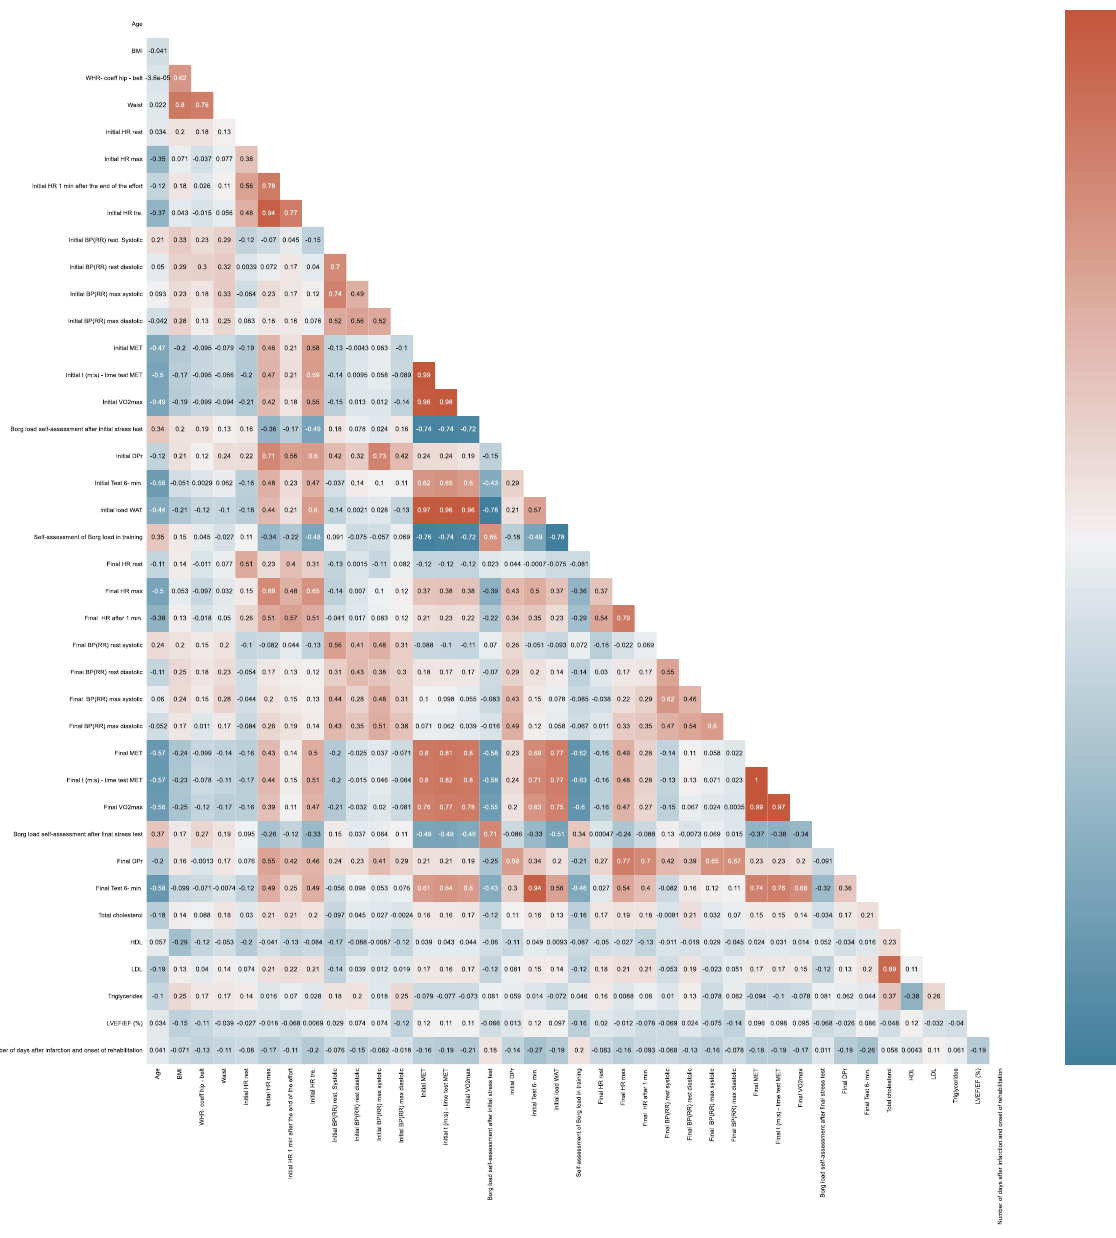
Figure 4. Correlation matrix between variables.